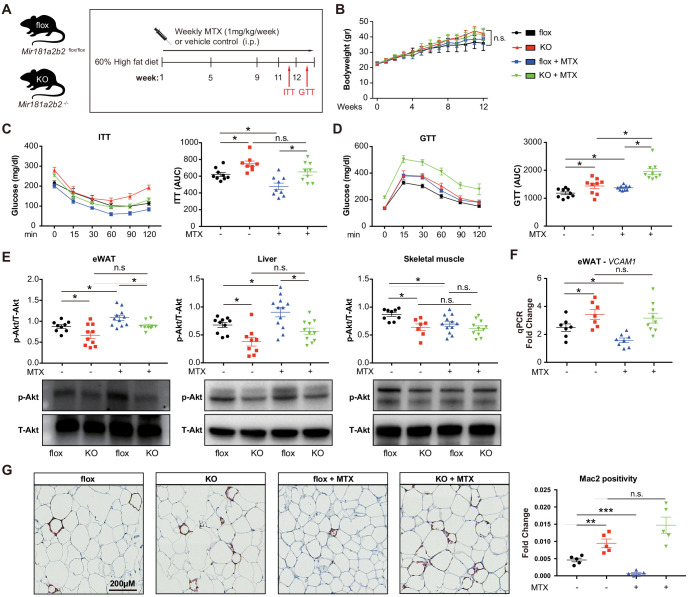
Systemic Mir181a2b2 KO blocks methotrexate (MTX)-mediated insulin sensitivity and visceral fat inflammation in diet-induced obesity.(A) Schema of experimental procedure for Mir181a2b2
flox/flox (flox) and Mir181a2b2—/— (KO) mice that were placed on a 60% high-fat diet (HFD) for 12 weeks. Each group of mice was weekly i.p. injected with vehicle control or MTX (1 mg/kg). (B) Body weights were measured weekly. Blood glucose levels were measured at week 11 for (C) insulin tolerance testing (ITT) and on week 12 for (D) glucose tolerance testing (GTT) with calculated area under the curves (AUC), respectively. (E) Western blot analysis of Akt and pSer473-Akt in epididymal white adipose tissue (eWAT), liver, and skeletal muscle with quantification across n = 3 independent experiments. (F) Real-time qPCR analysis of VCAM-1 expression in eWAT. (B–F), n = 9–10 mice per group, one-way ANOVA. (G) Paraffin sections of eWAT were stained with Mac2 and the positive areas were quantified, n = 5 mice per group, one-way ANOVA. *p<0.05; **p<0.01; ***p<0.001. All values represent mean ± SEM.